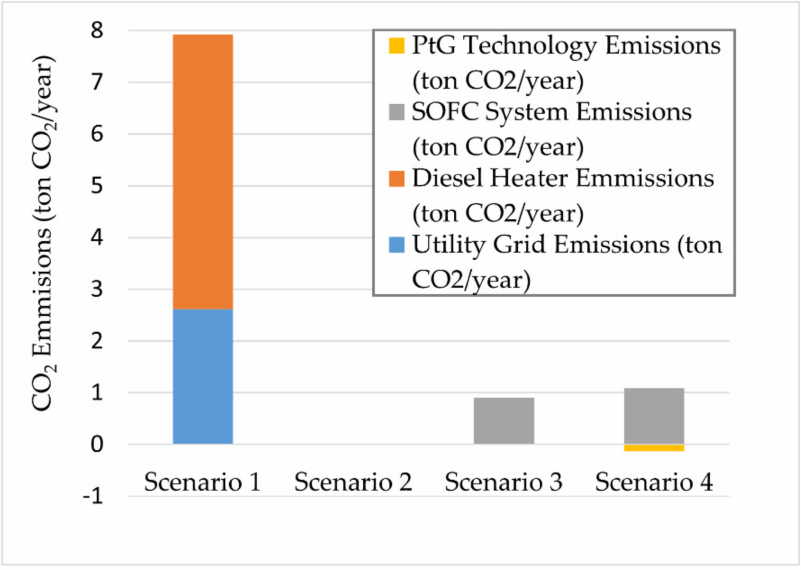
Figure 9. ThetotalamountoftheproducedCO 2 emissionsineachscenarioaccordingtotheintegratedsystem.